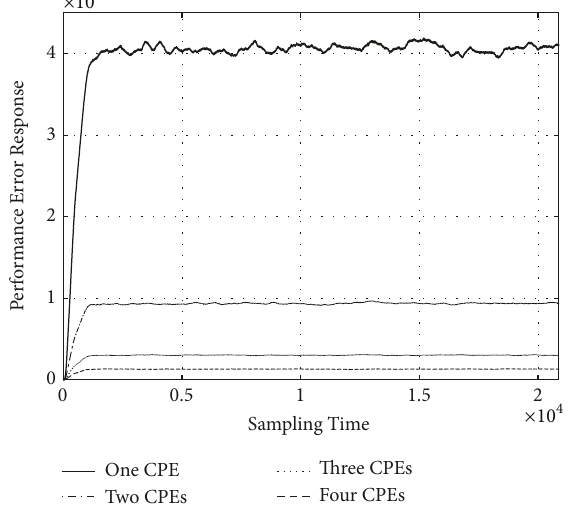
Figure 8: Simulation estimation of the performance error response for different redundant structures subject to common-source digital upsets under a certain simulated electromagnetic